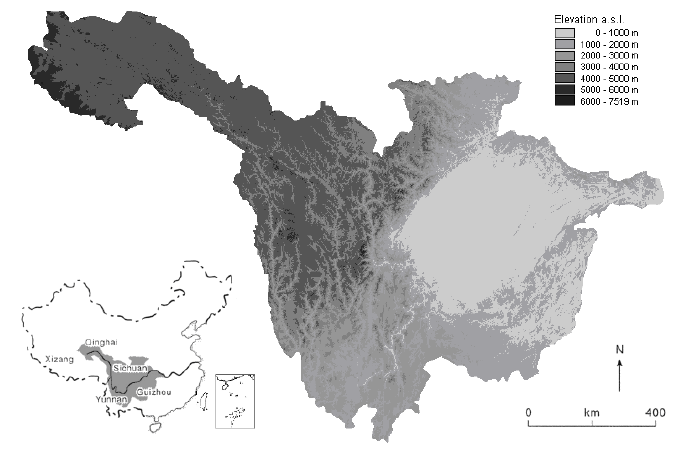
Figure 1. Location and topographical situation of the study